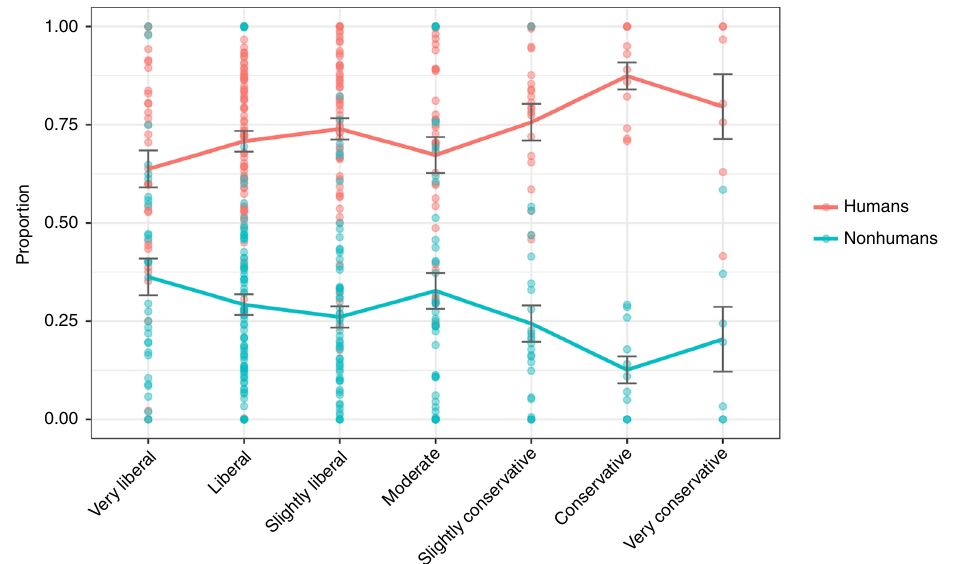
Fig. 6 Proportion of moral allocation by ideology, Study 3b. Error bars represent standard errors, solid lines indicate means. Source data are provided as a Source Data fi